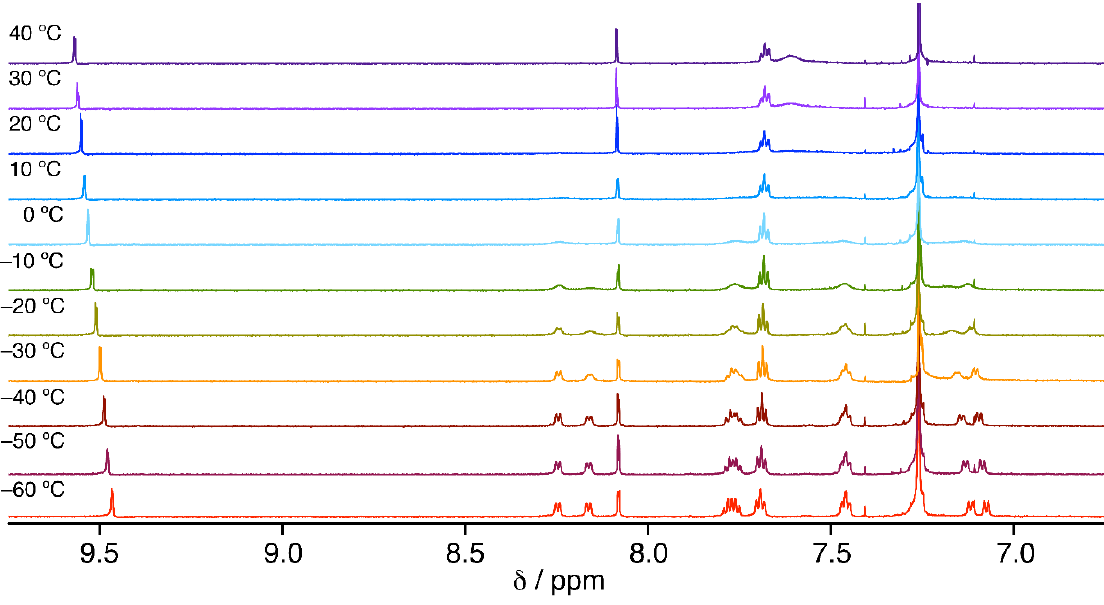
Figure 2. Variable-temperature 1 H NMR spectra of 4 in CDCl 3 .